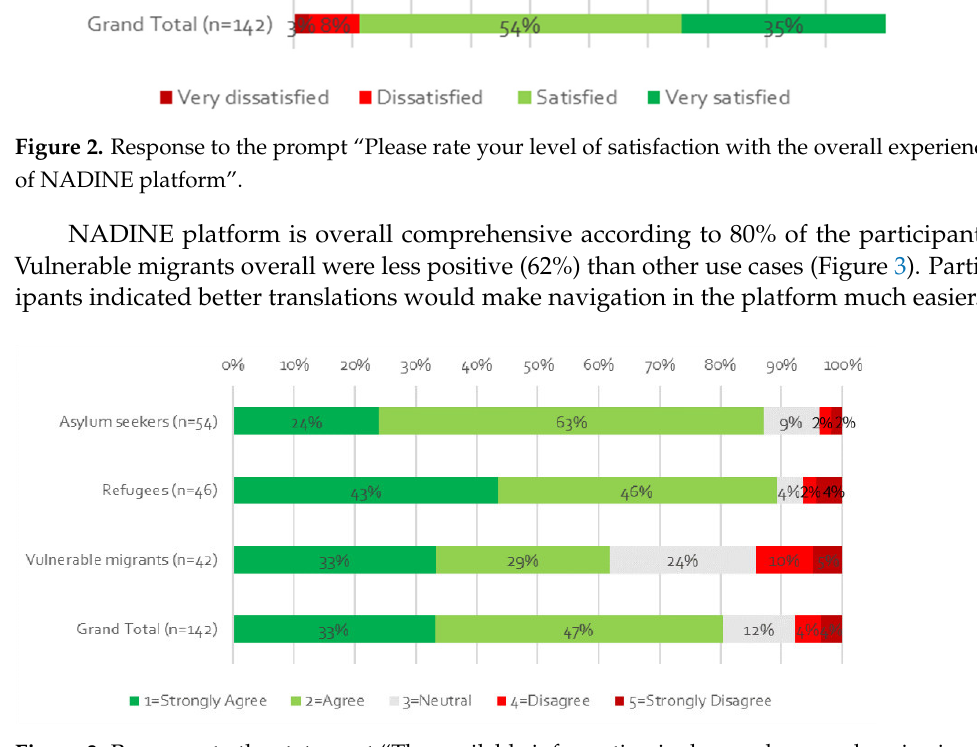
Figure 3. Response to the statement “The available information is clear and comprehensive in my language”.